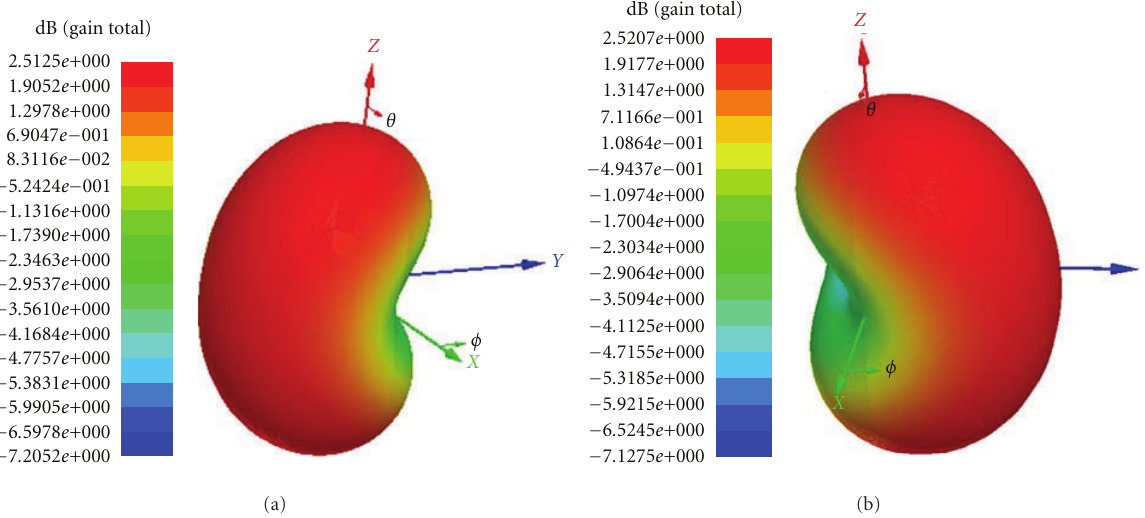
Figure 5: Simulated 3D radiation pattern at 0.9 GHz. (a) Antenna 1 excited. (b) Antenna 2 excited.